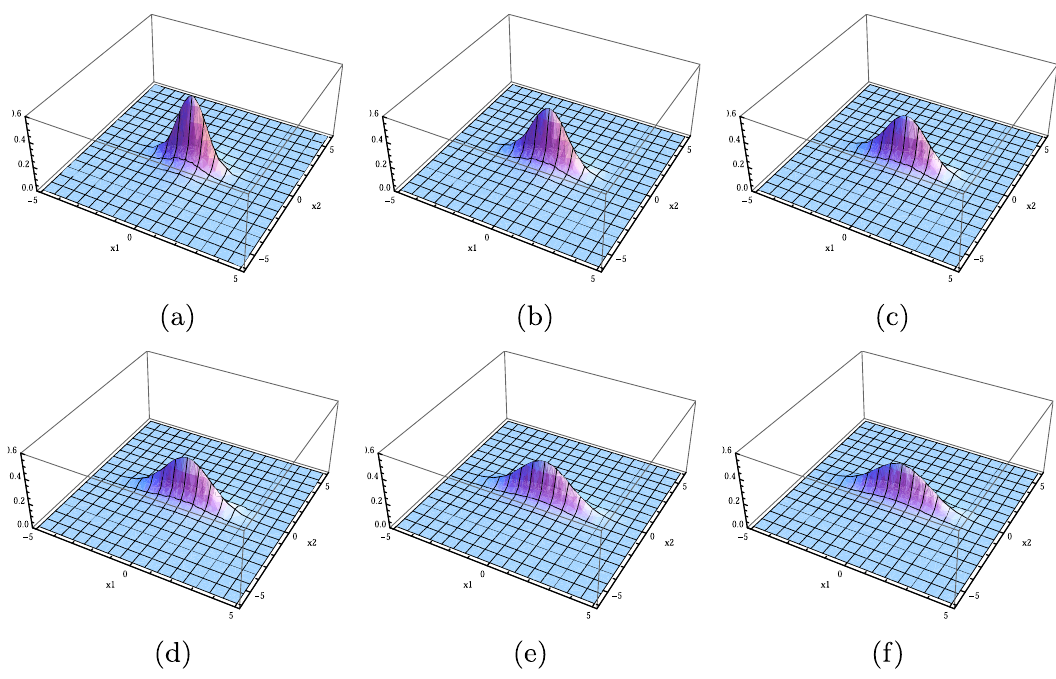
Figure 7: The shape of transition function ( ) p x x , 1 2 when we fi x = t 0.3 , = b 1 and a changes from 1 to 3.5 in the interval of 0.5.